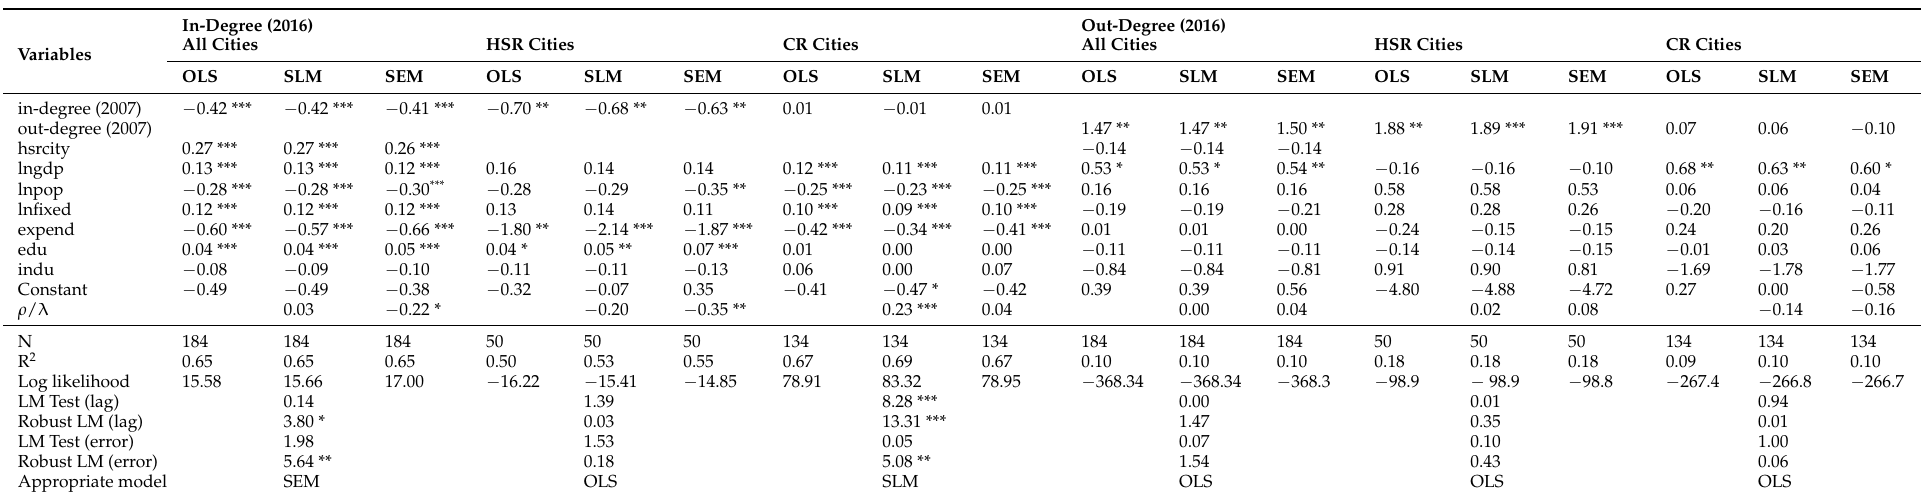
Table 5. Regression results for in-degree and out-degree in